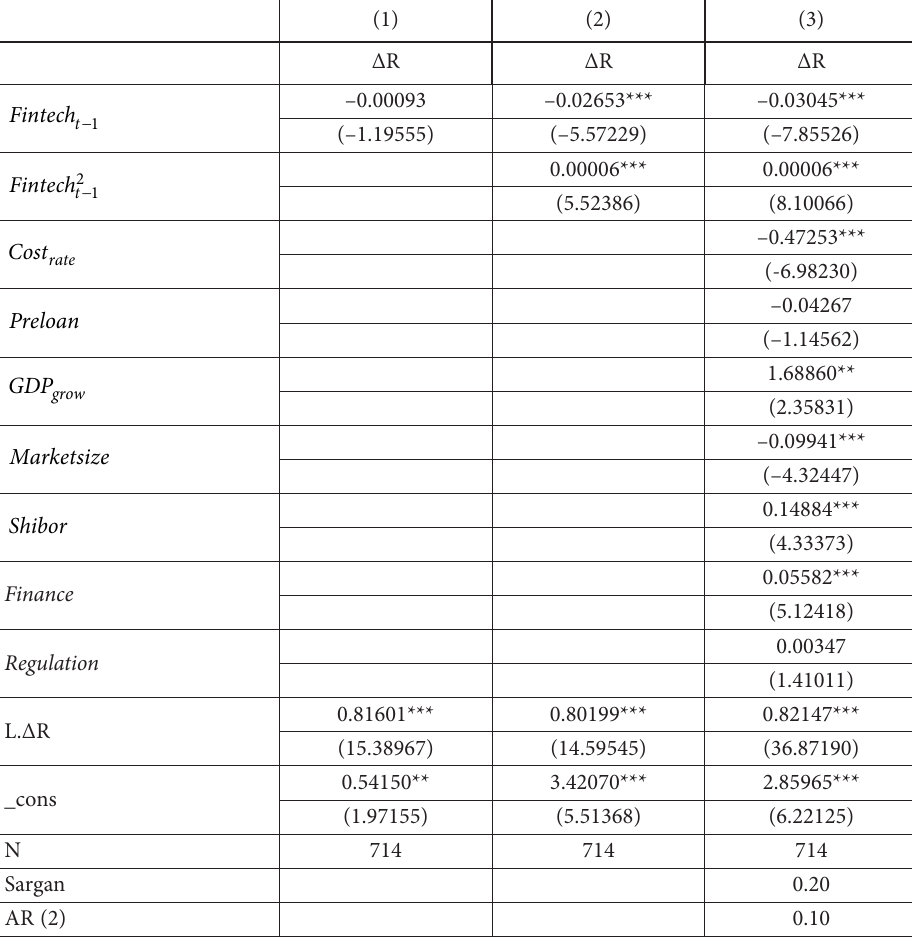
Table 2. Benchmark regression results for H1